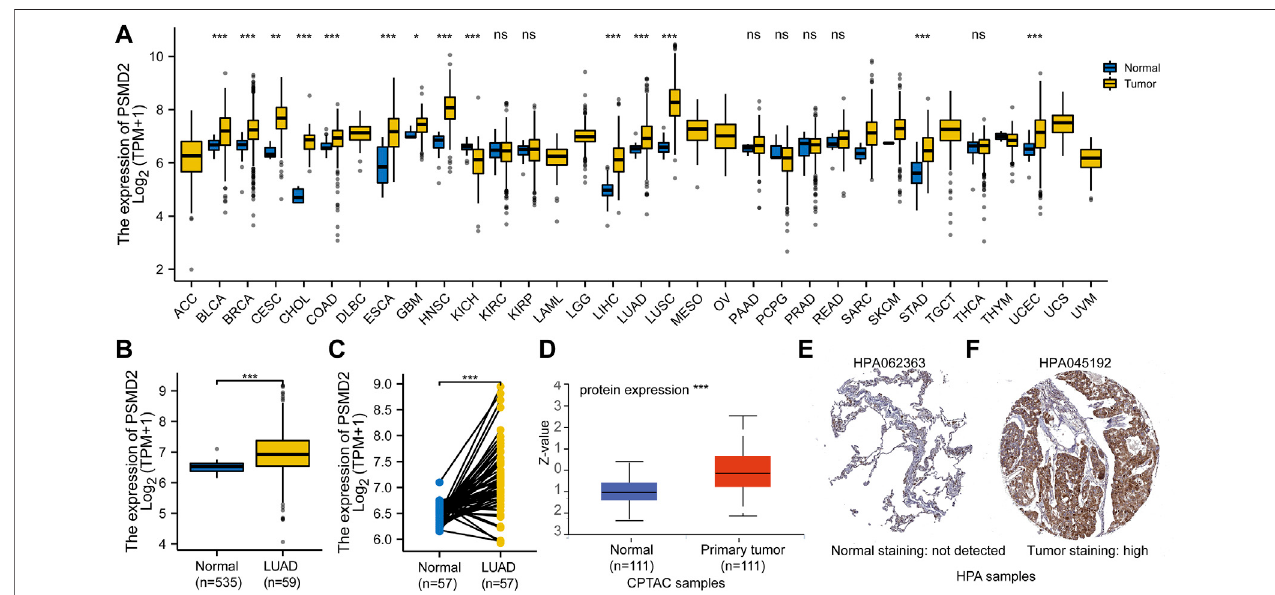
FIGURE1| Expressionpatternof PSMD2 inPan-cancerperspectiveandlungadenocarcinoma. (A) PSMD2 isincreasedin13cancertypesanddecreasedonlyin Kidney Chromophobefrom TCGA. (B,C) Both theMann-Whitney Utest and paired t-test indicate mRNA expression of PSMD2 iselevated in lung adenocarcinoma. (D) The protein expression of PSMD2 is upregulated in CPTAC. (E) The PSMD2 protein expression in normal tissue from HPA. (F) The PSMD2 protein expression in lung adenocarcinoma tissue from HPA. ( p p < 0.05, pp p < 0.01, ppp p < 0.001, ns, no signi fi cant).